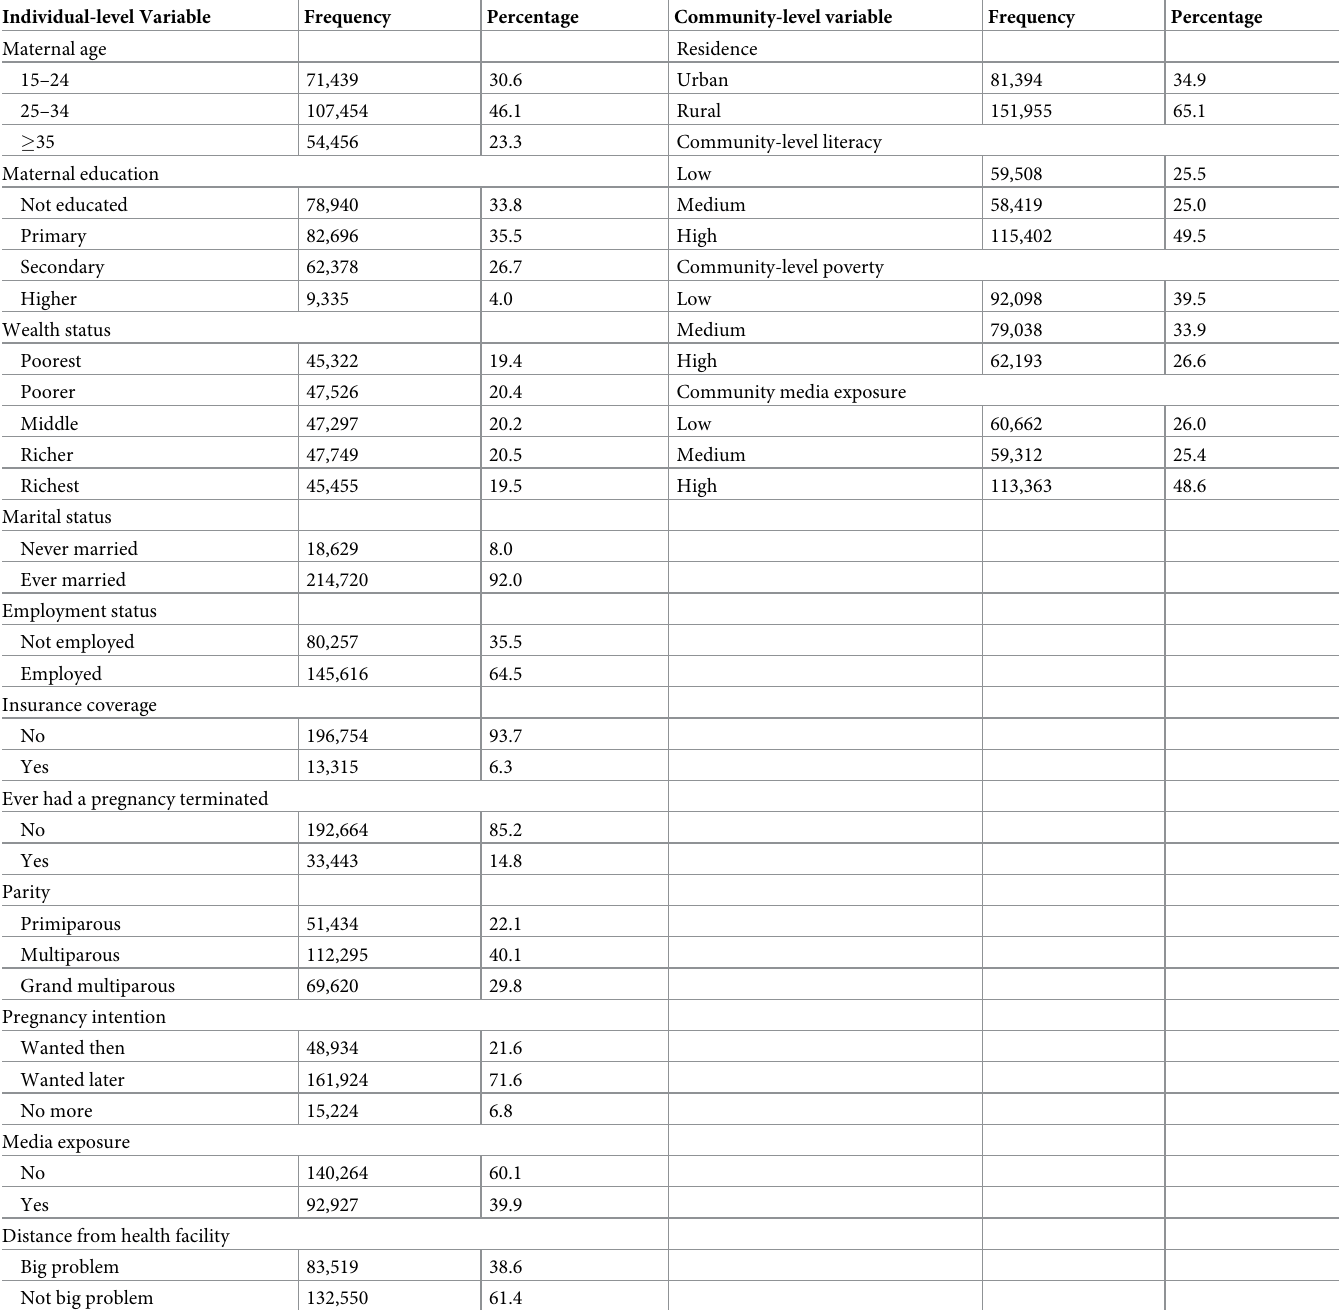
Table 2. Background characteristics of the study